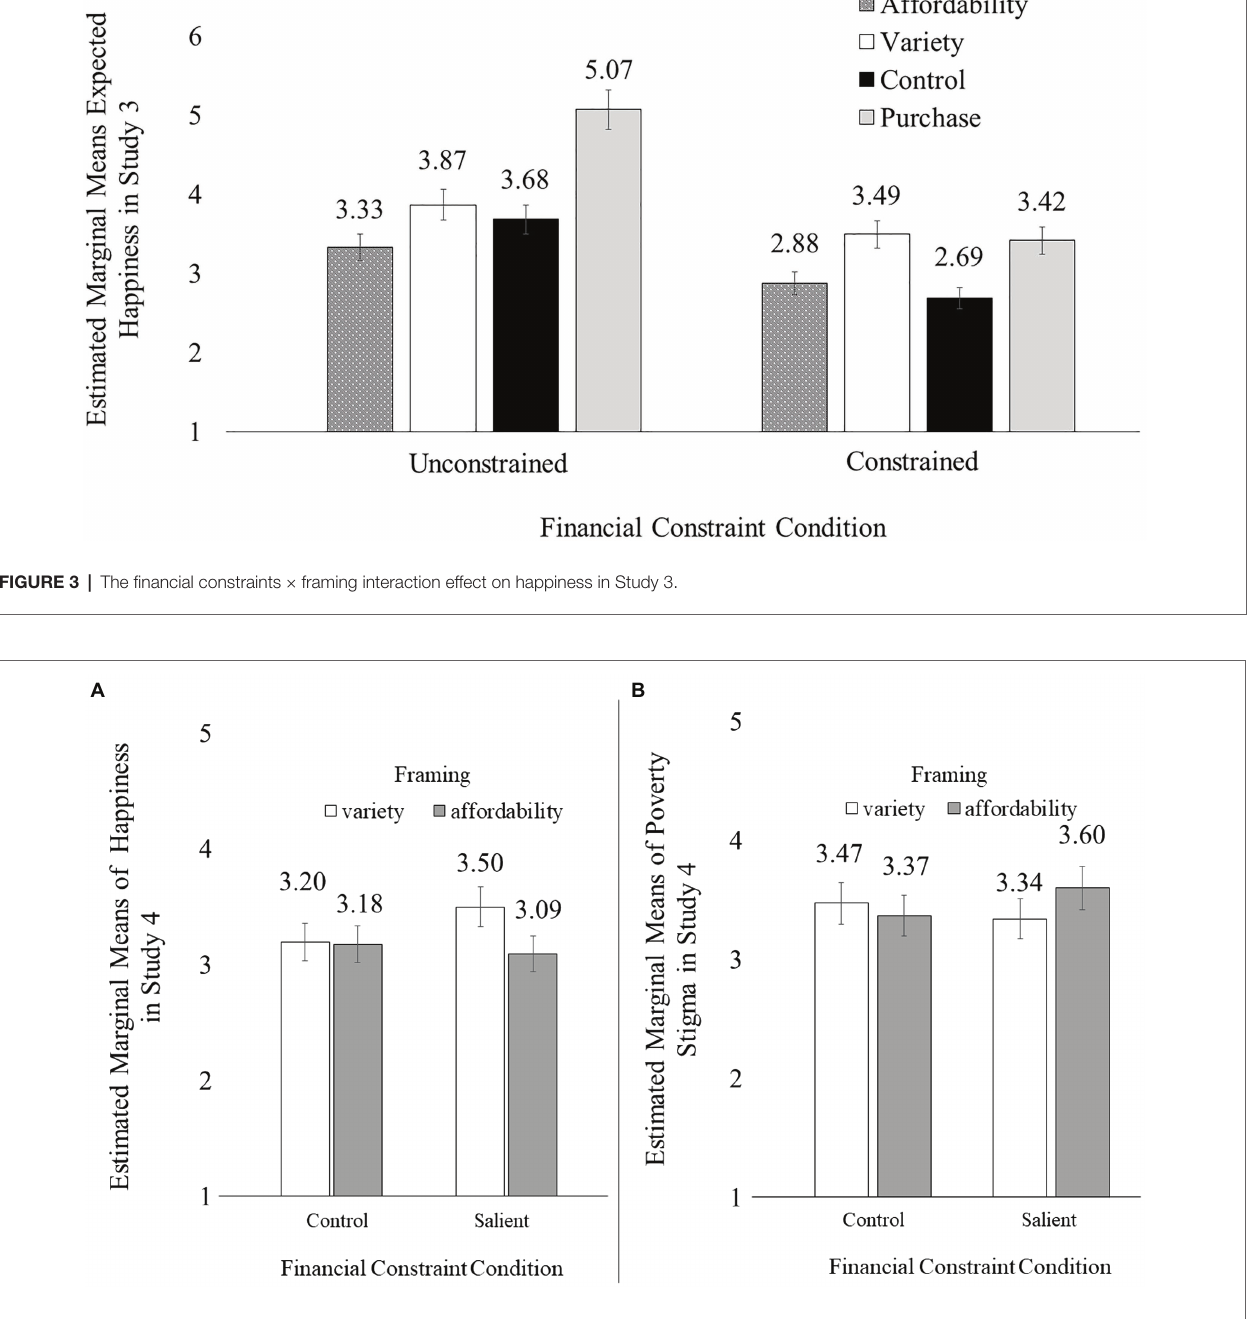
FIGURE 4 | The financial constraints × framing interaction effect on happiness (A) and poverty stigma (B) , respectively, in Study